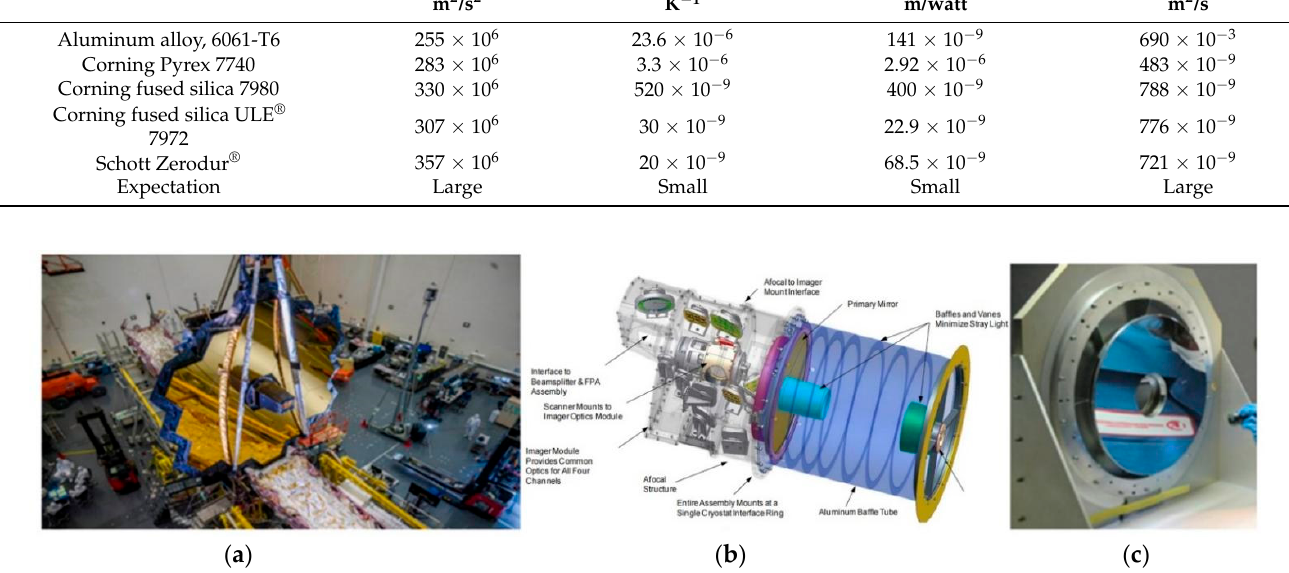
Figure 1. ( a ) The primary mirror of JWST; ( b ) Optomechanical system of WISE; ( c ) Primary mirror of WISE [14,15]. Table 1. Relative figures of merit for aluminum and glass mirror substrate materials [3] .